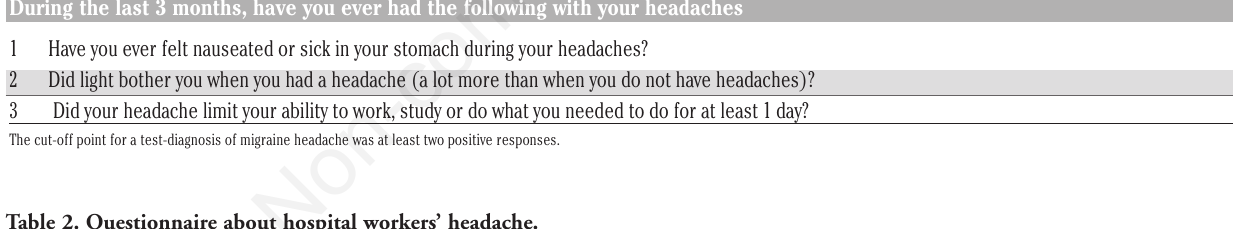
Table 2. Questionnaire about hospital workers’ headache.